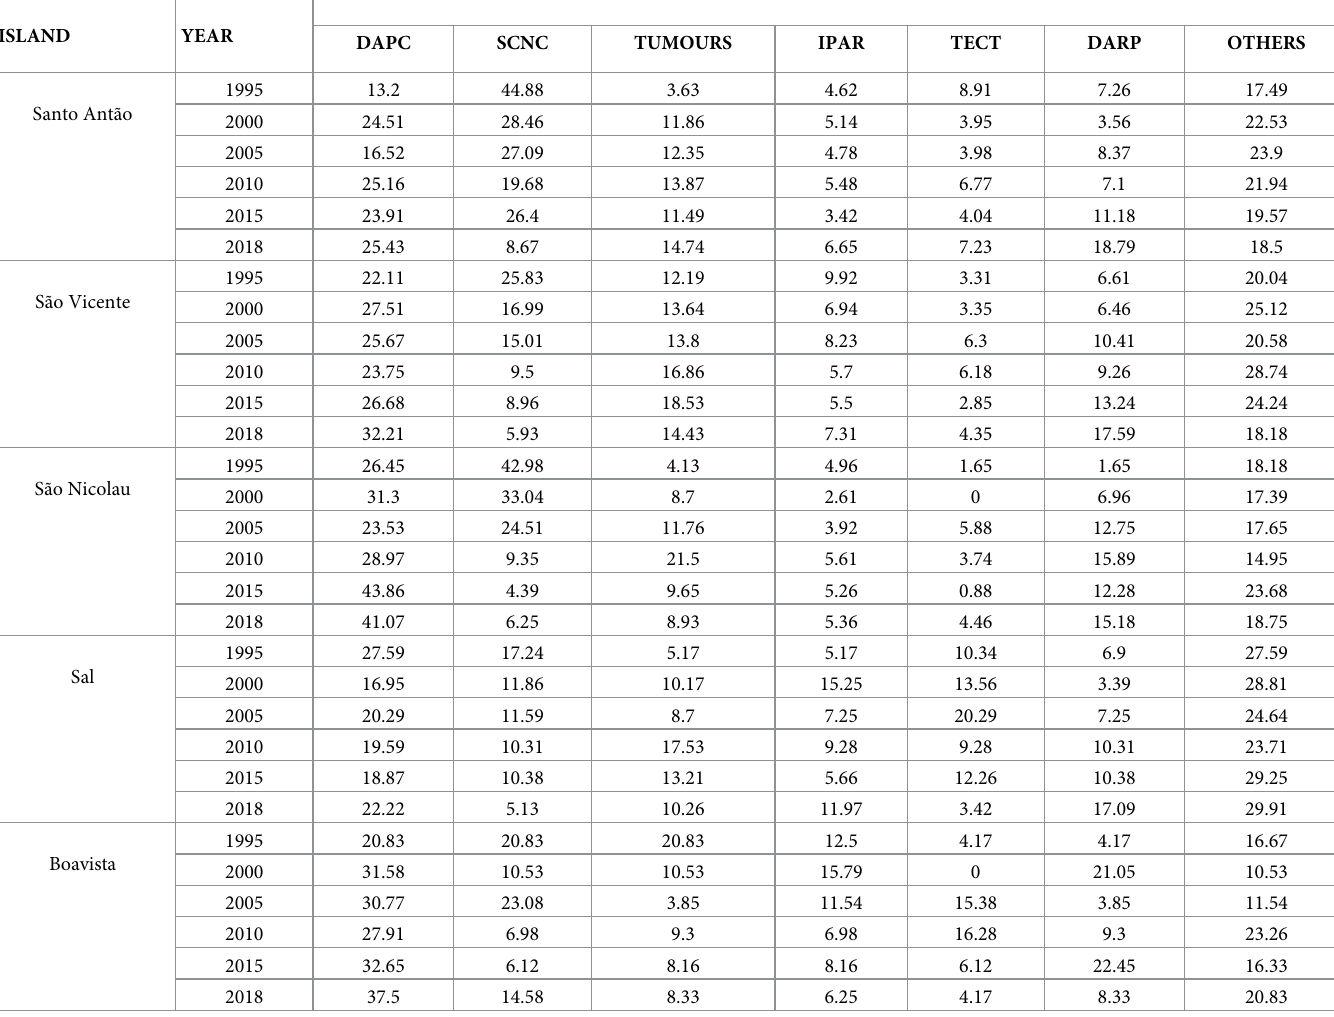
Table 1. Distribution of mortality by group and cause of death (%) in the Barlavento Islands. ISLAND YEAR DAPC SCNC